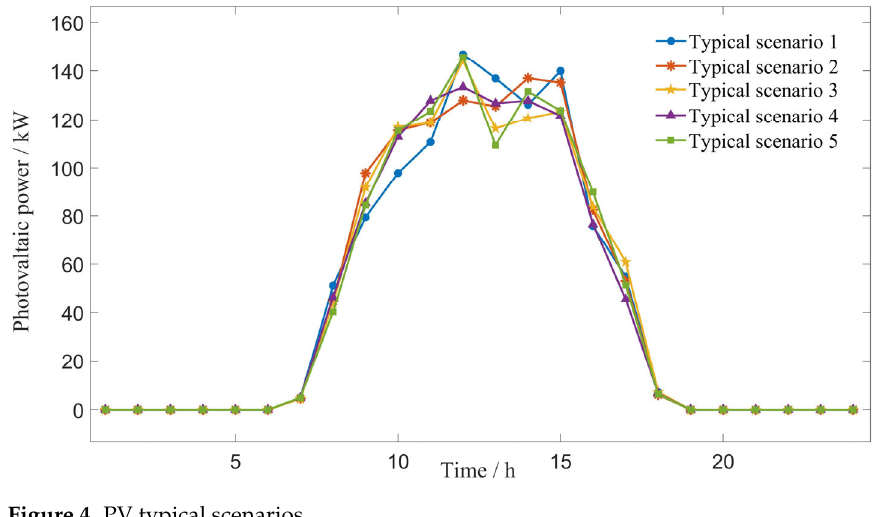
Figure 4. PV typical scenarios.